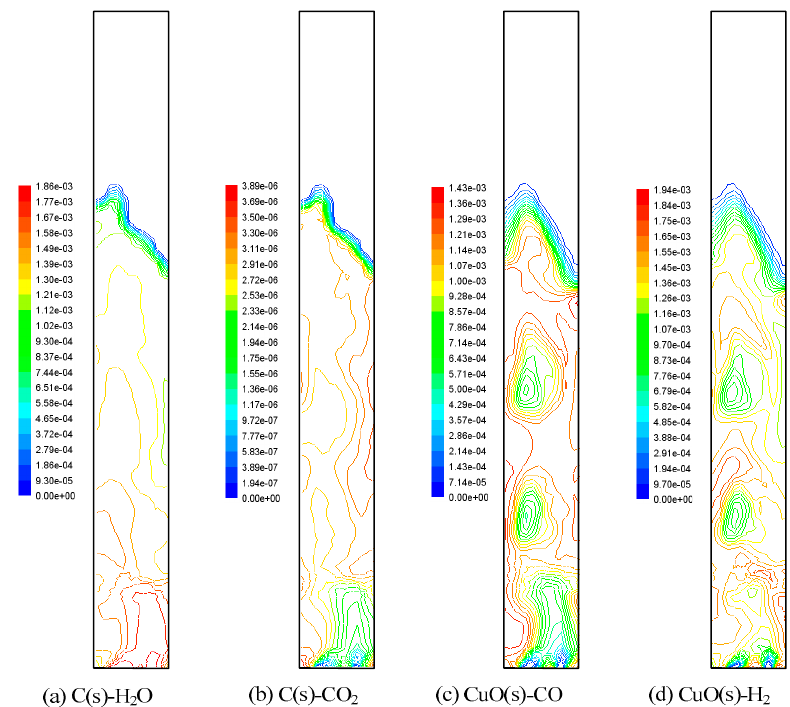
Figure 7. Distributions of heterogeneous reaction rates (H b = 1.1 m, Qc = 1.6 kg / h, U / U mf = 6, T b = 1073 K). ( a ) C(s)-H 2 O rate; ( b ) C(s)-CO 2 rate; ( c ) CuO(s)-CO rate; ( d ) CuO(s)-H 2 rate.